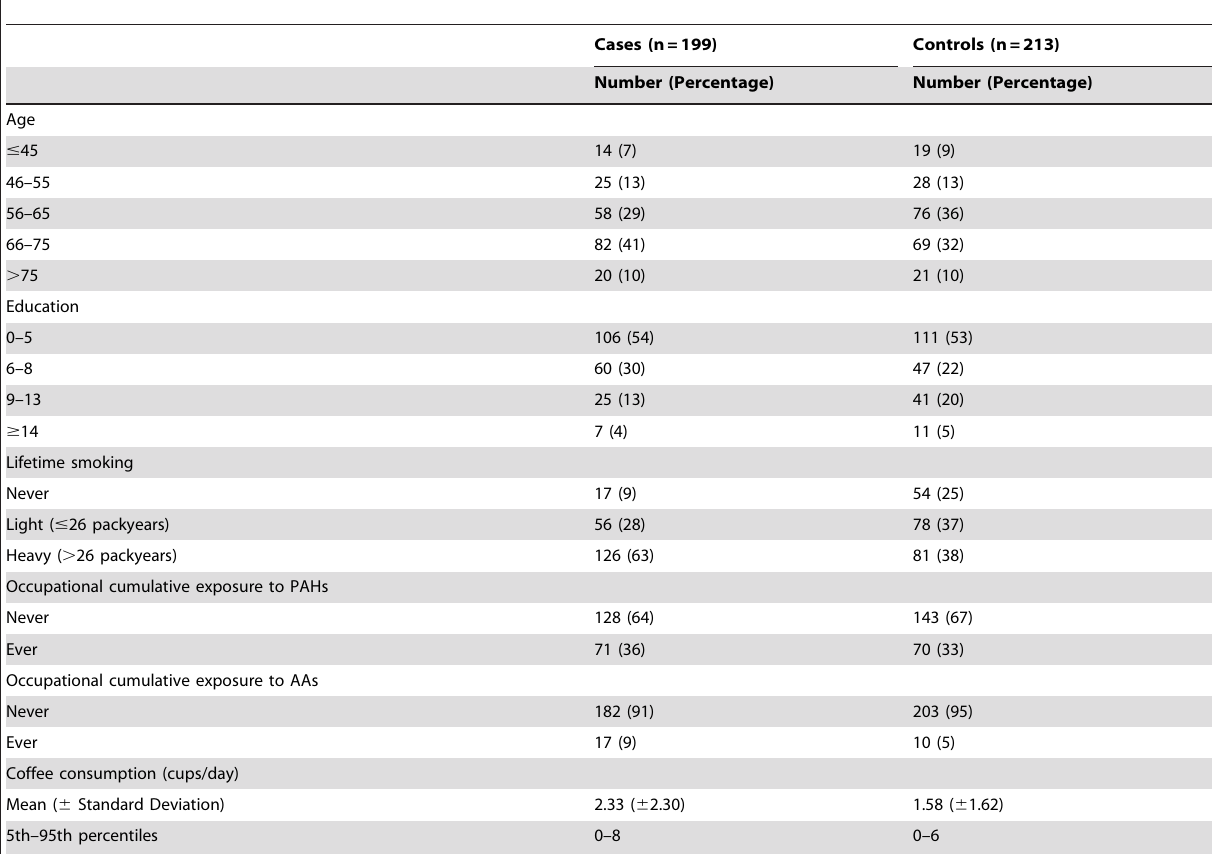
Table 1. Distribution of demographic characteristics, life habits, and occupational exposures in cases and controls.